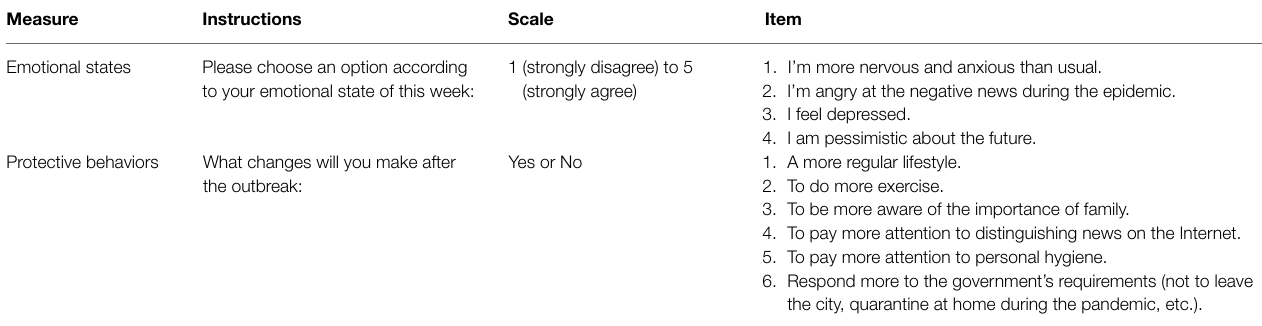
TABLE 1 | Items for the emotional states scale and protective